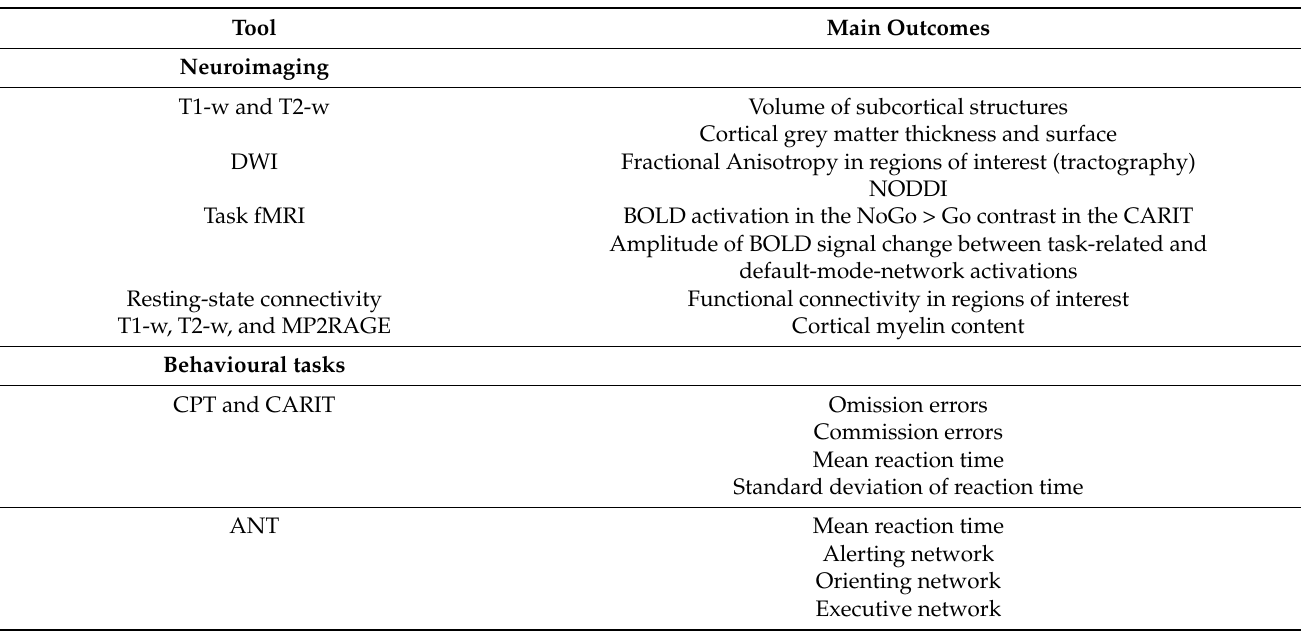
Table 4. List of the main outcomes of the